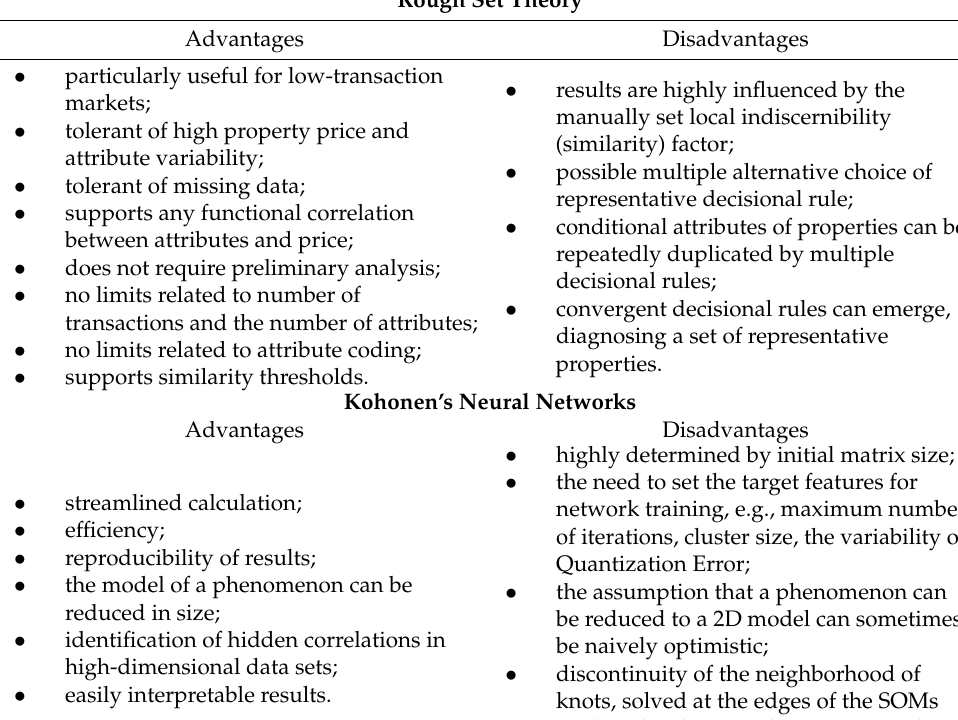
Table 10. The major practical advantages and disadvantages of selected methods. Source: own